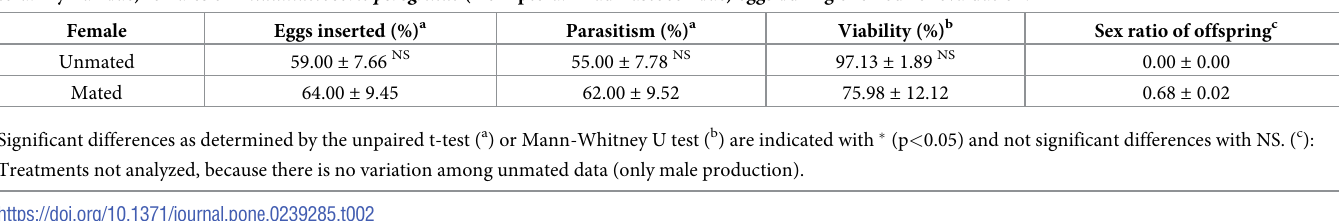
Table 2. Eggs inserted (%), parasitism (%), viability (%) and sex ratio of offspring (mean ± standard error) of unmated and mated Cleruchoides noackae (Hymenop- tera: Mymaridae) females on Thaumastocoris peregrinus (Hemiptera: Thaumastocoridae) eggs during one hour of evaluation. Female Eggs inserted (%) a